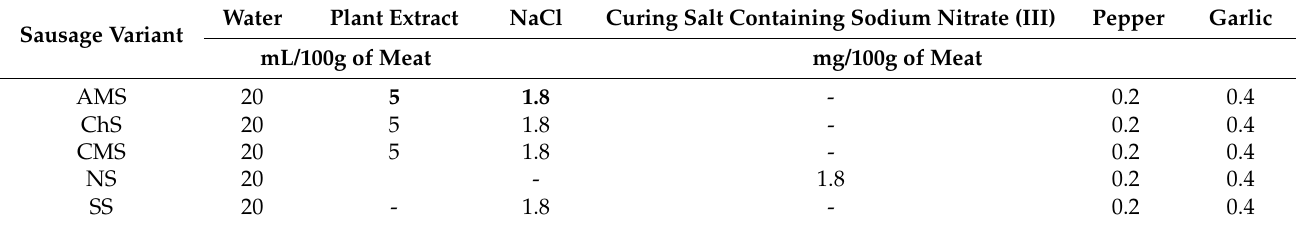
Table 4. Content of additives in the sausage